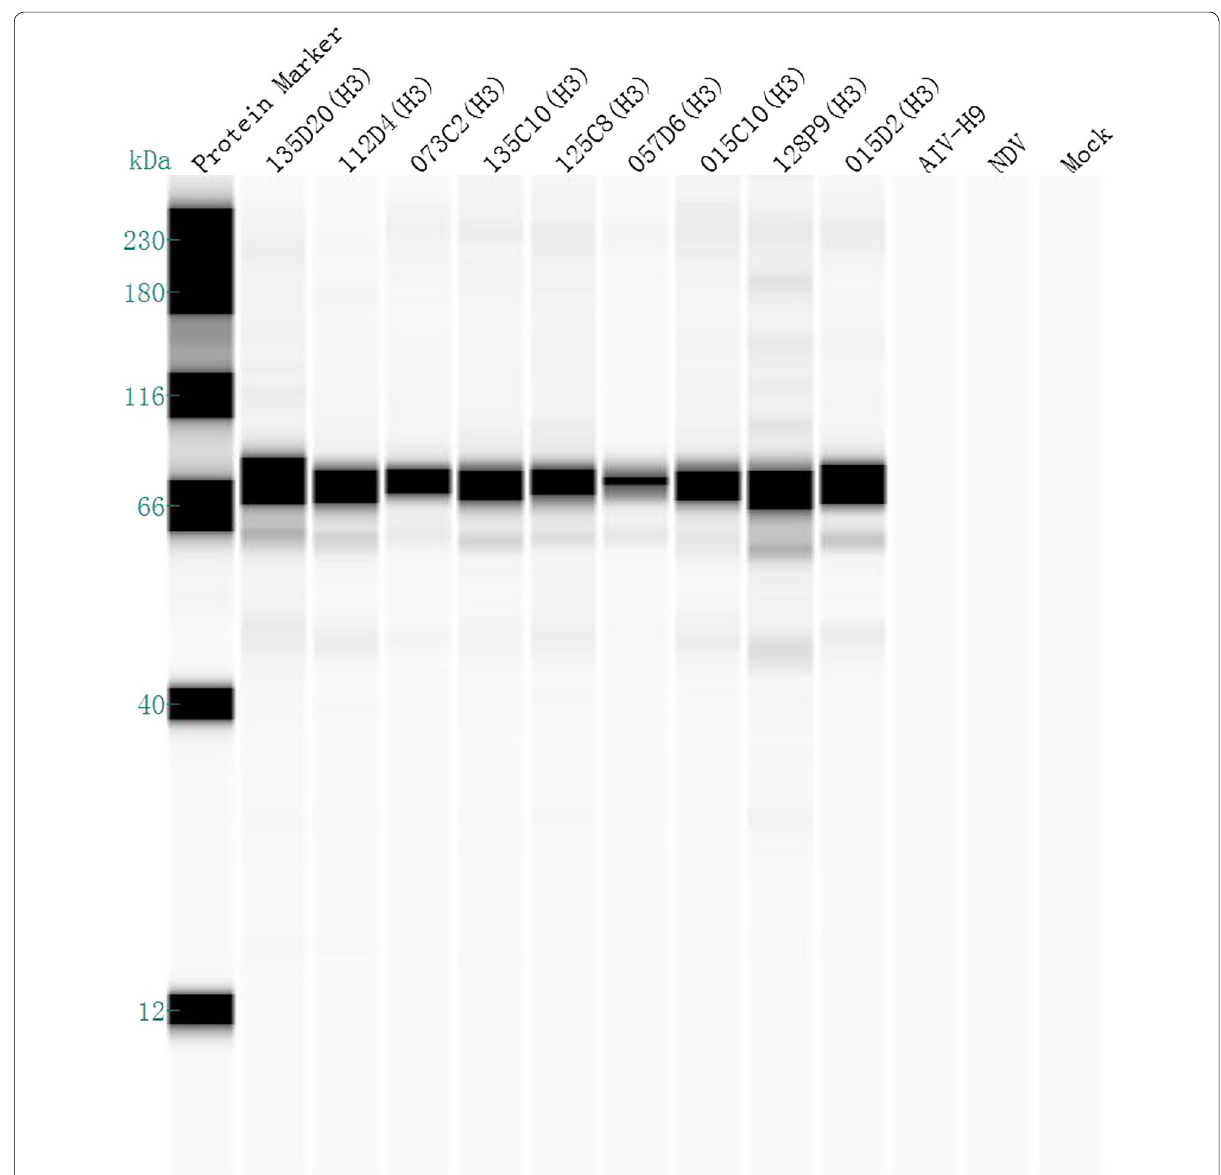
Fig. 1 The reactivities of different H3 isolates with the mAb 9F12 were determined in a Western blot